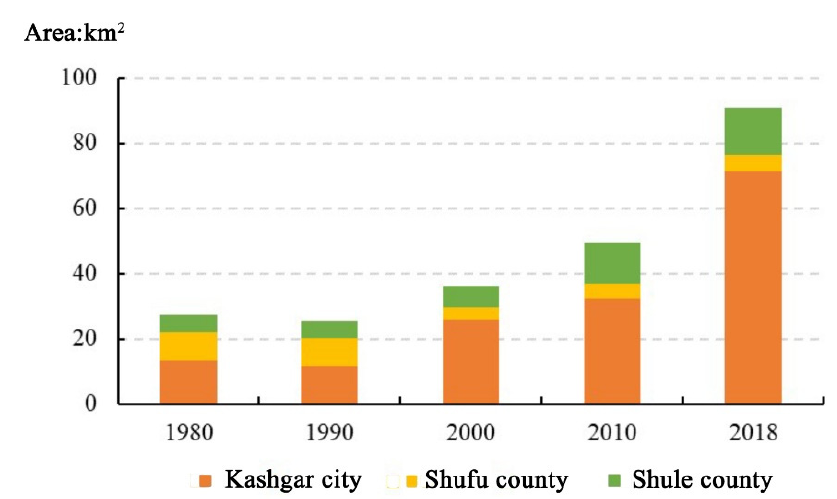
Figure 7. The changes in the urban built-up area from 1980 to 2018.